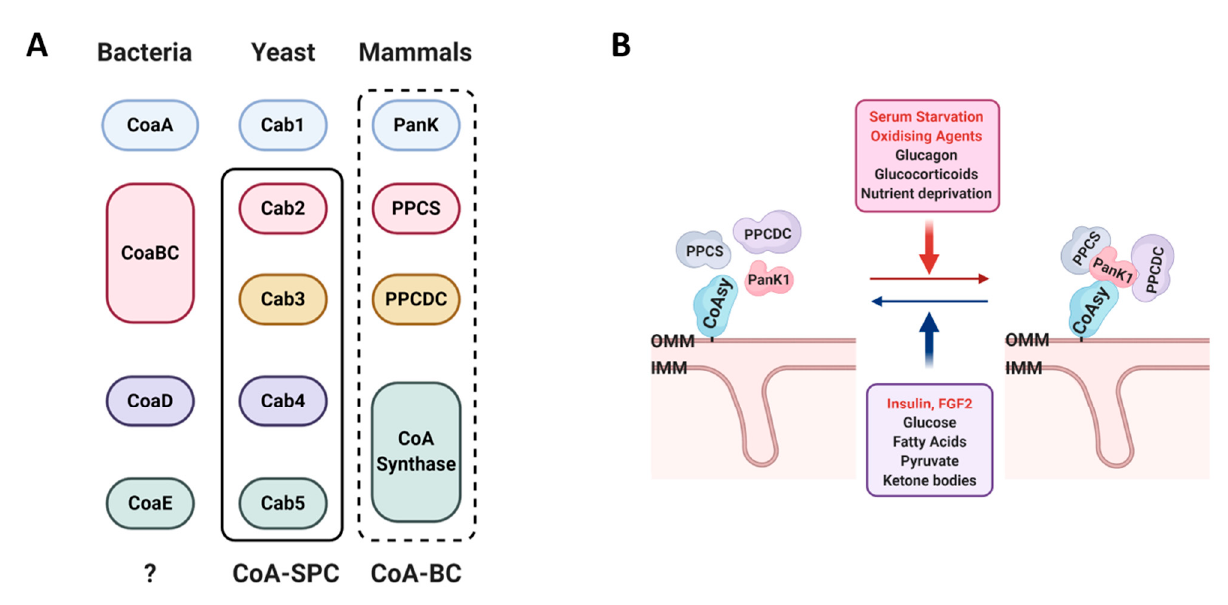
Figure 7. ( A ) Key players of the CoA biosynthetic pathway in bacteria, yeast and mammals. Solid rectangle indicates components of the CoA-synthesizing protein complex (CoA-SPC) described in yeast [18]. Dotted rectangle indicates a potential CoA biosynthetic complex (CoA-BC) in mammalian cells. ( B ) Negative and positive regulators of CoA biosynthesis in mammalian cells. Apart from the outer mitochondrial membrane (OMM), CoAsy was found to be localized in the mitochondrial matrix and nucleus [18,26,30,31].